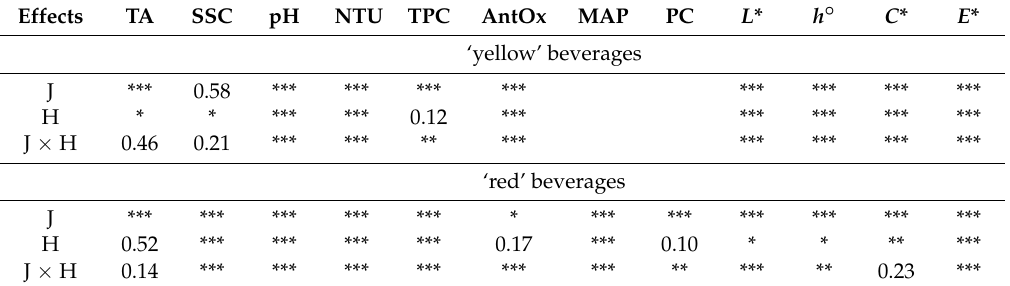
Table 1. Significative influence (* p < 0.05; ** p < 0.01; *** p < 0.001) of the main factors juice used in the preparation of the RCW-based beverages (J), heat treatment (H) and their interaction on physicochemical parameters and antioxidants of ‘yellow’ and ‘red’ fruit-RCW beverages. Non-significant differences are given as exact p